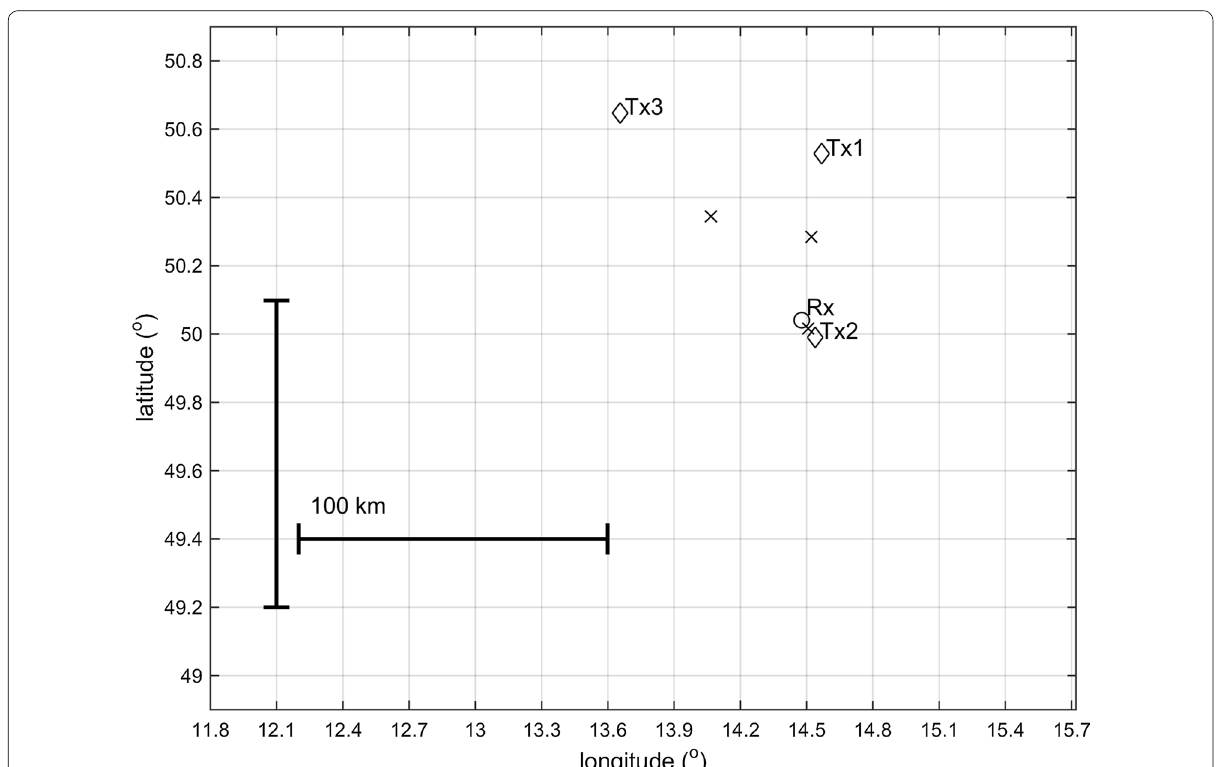
Fig. 1 Geographical locations of transmitters (diamonds), receiver (circle) and assumed reflection points (crosses) of the CDSS installed in the